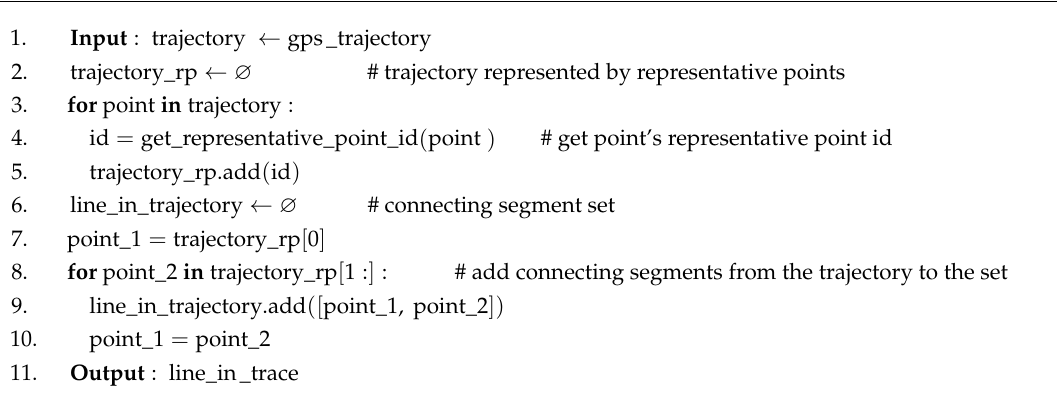
Algorithm 2 Connecting segment extraction algorithm